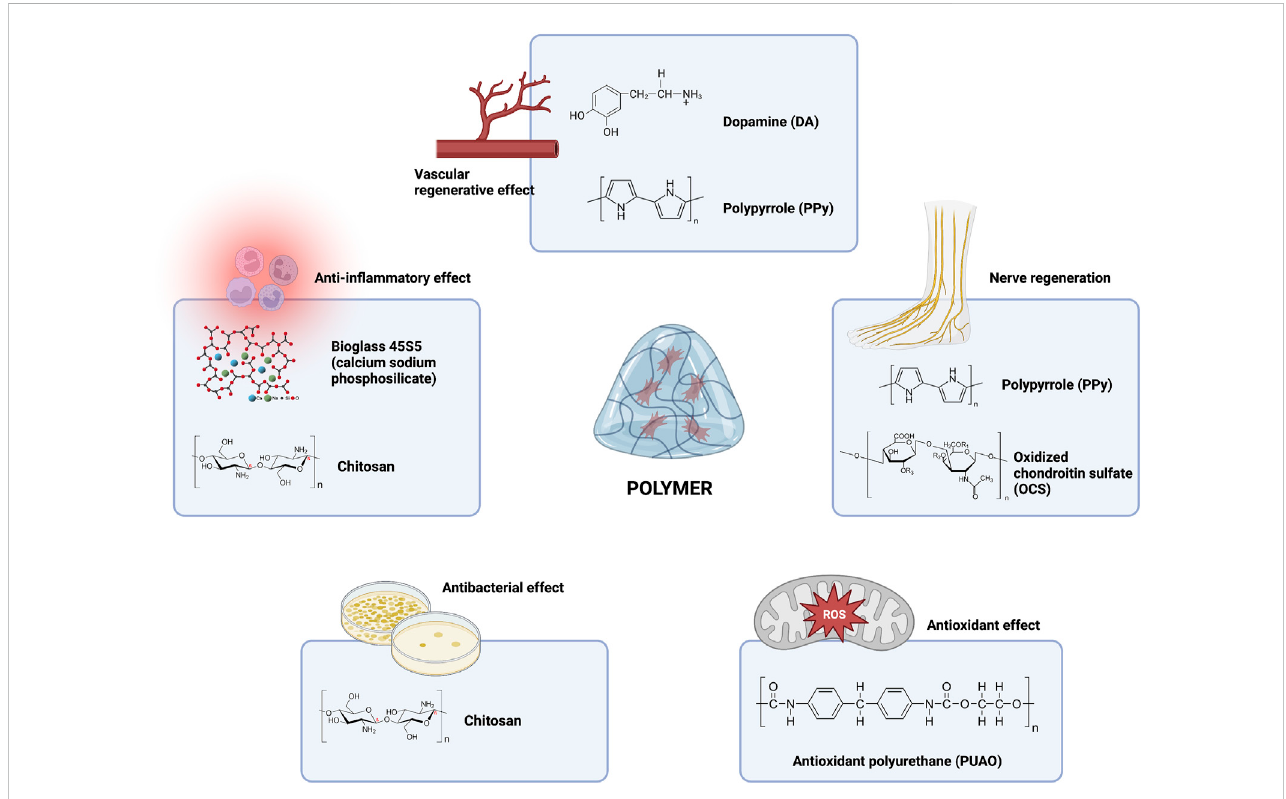
FIGURE 2 Current and future outlook of polymer components in hydrogel composites in the treatment of chronic diabetic